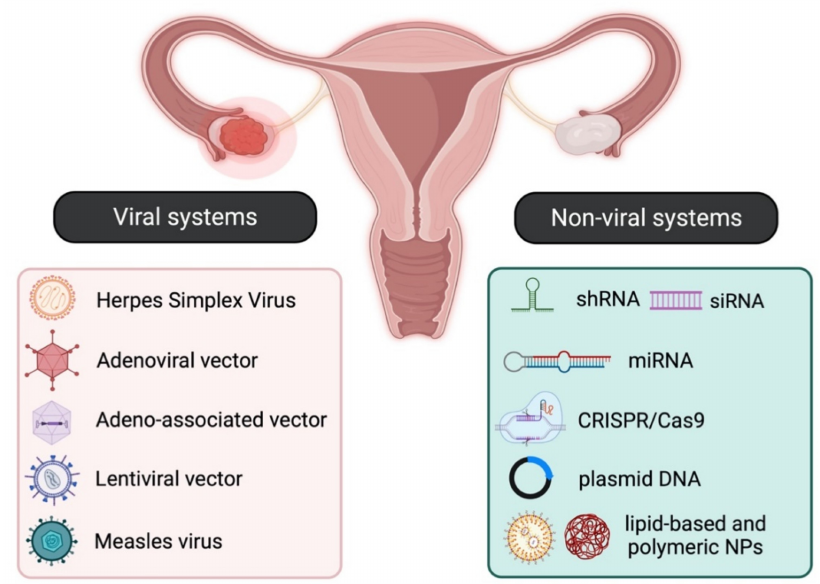
Figure 3. Gene therapy strategies for ovarian cancer. These employ viral vectors, such as Herpes Simplex Virus, adenoviral and adeno-associated viral vectors, lentiviral vectors and Measles virus, and non-viral systems, such as shRNA/siRNA/miRNA, DNA plasmids, lipid-based and polymeric NPs and CRISPR/Cas9 approaches. Of note, some of the above approaches, e.g., shRNA, were also delivered via lentiviral